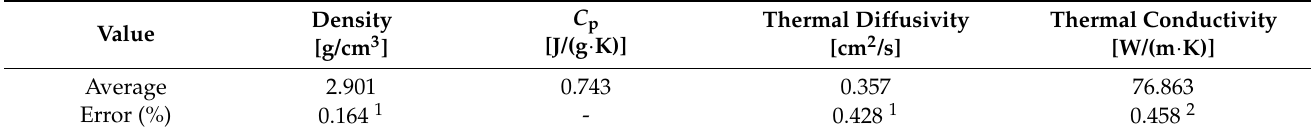
Table 2. Calculated ( C p ) or experimental (density and thermal diffusivity) values to determine thermal conductivity.